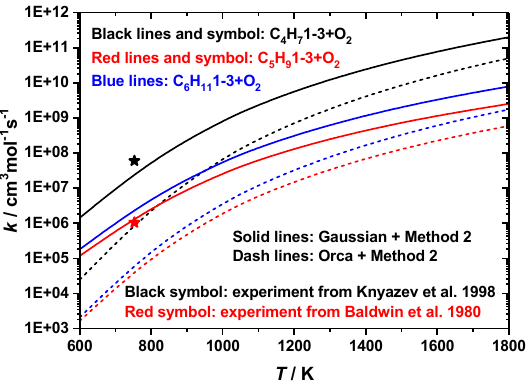
Solid lines: Gaussian + Method 2 Dash lines: Orca + Method 2